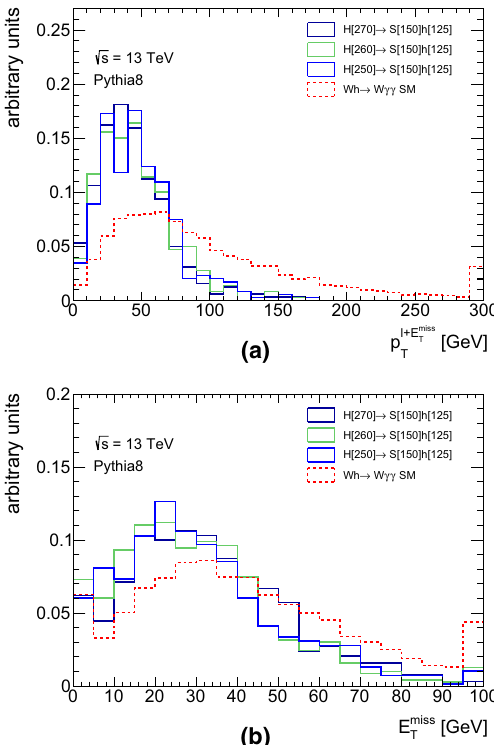
Fig. 8 Transverse momentum of the lepton and the E miss system in T events with two photons and a lepton ( a ) and missing transverse energy (cid:4) + E miss < 150 GeV (b ) for several H → Sh samples T after requiring p T (solid lines) compared with the SM Wh process with h → γγ (dashed line) generated with PYTHIA8 . The last bin contains overflow